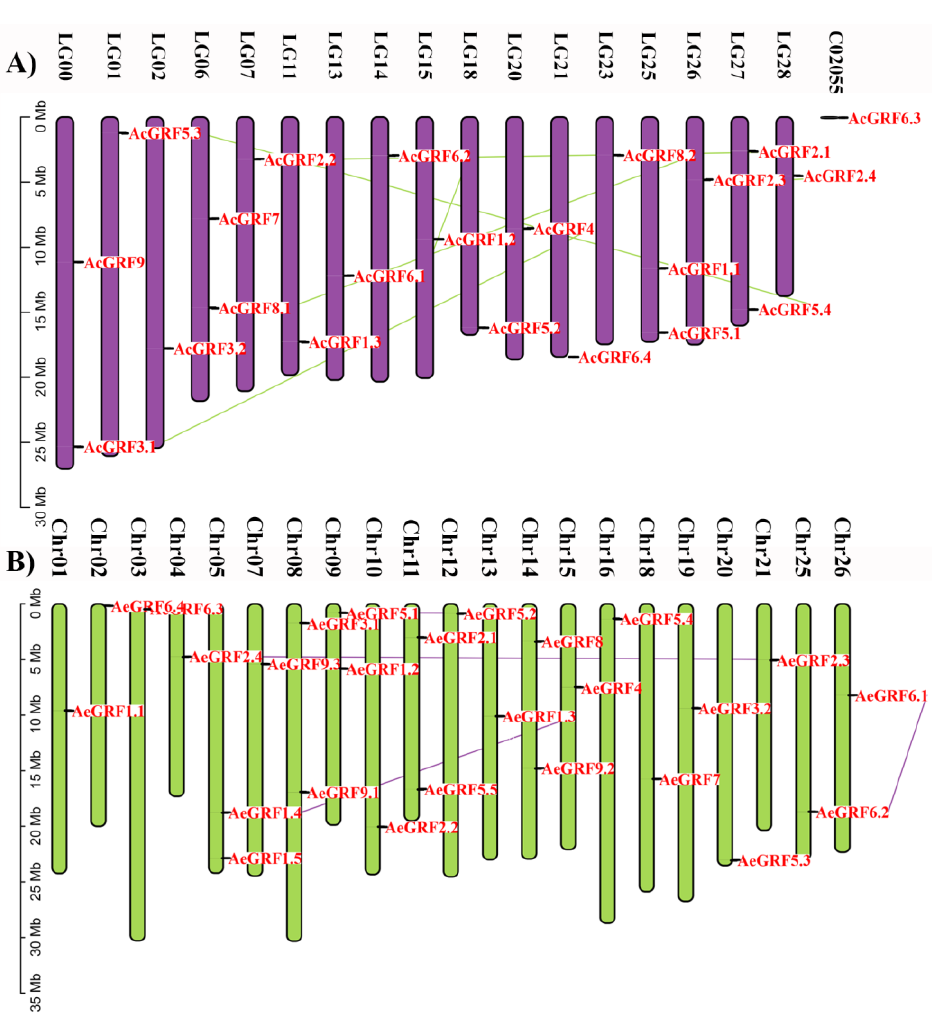
Figure 2. Chromosomal distribution of ( A ) AcGRF genes, and ( B ) AeGRF genes. The colored lines in the background show homologous gene pairs.